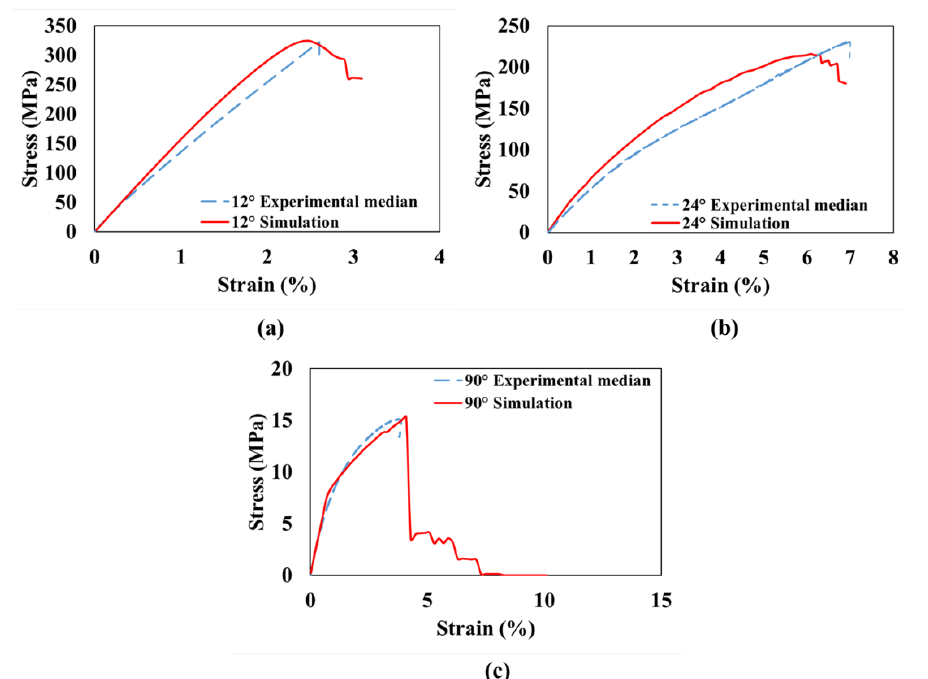
Figure 10. Comparison of stress-strain curves from the experiment and simulation for single-angled 3D-printed GFRP composite with ( a ) ± 12°, ( b ) ± 24°, and ( c ) ± 30°.